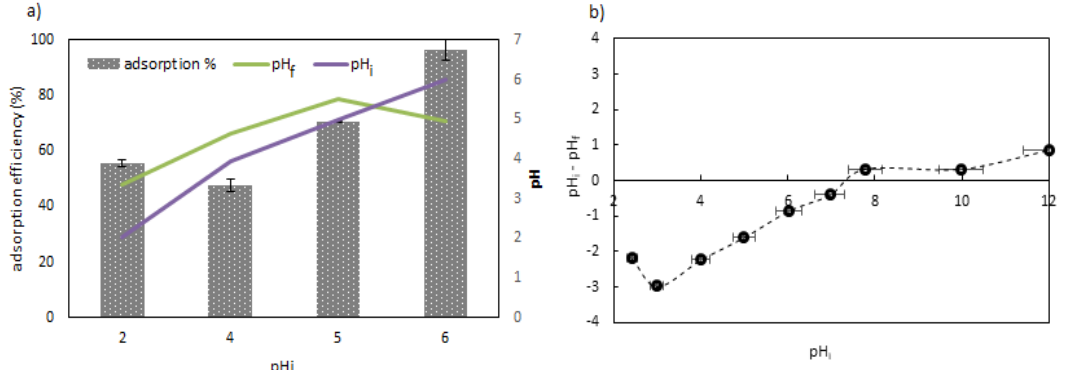
Figure 3. Effect of pH on antimony adsorption from aqueous solutions. ( a ) Performance of ChiFer(III) at different pHs (T = 20 °C; C o : 50 mg/L; dose: 1 g/L; contact time: 24 h; agitation rate: 150 rpm), ( b ) pH pzc of ChiFer(III) (T = 20 °C; Electrolite: NaCl 0.01 M; dose: 1 g/L; contact time: 24 h; agitation rate: 150 rpm). pH i = initial pH; pH f = final pH.